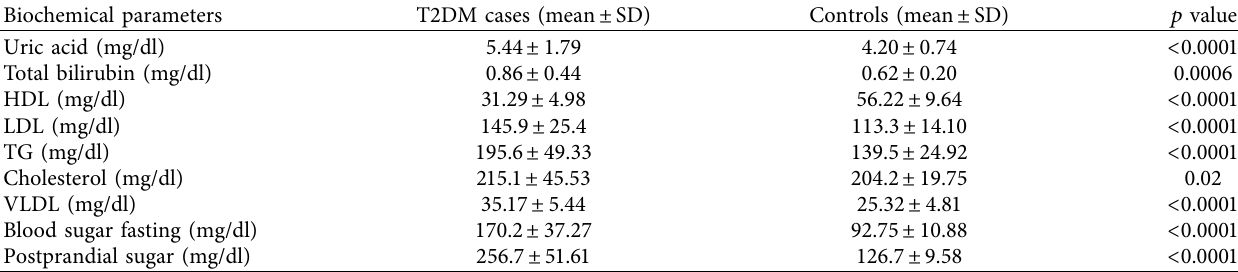
Table 2: Comparison of biochemical parameters among T2DM cases and healthy controls. Biochemical parameters